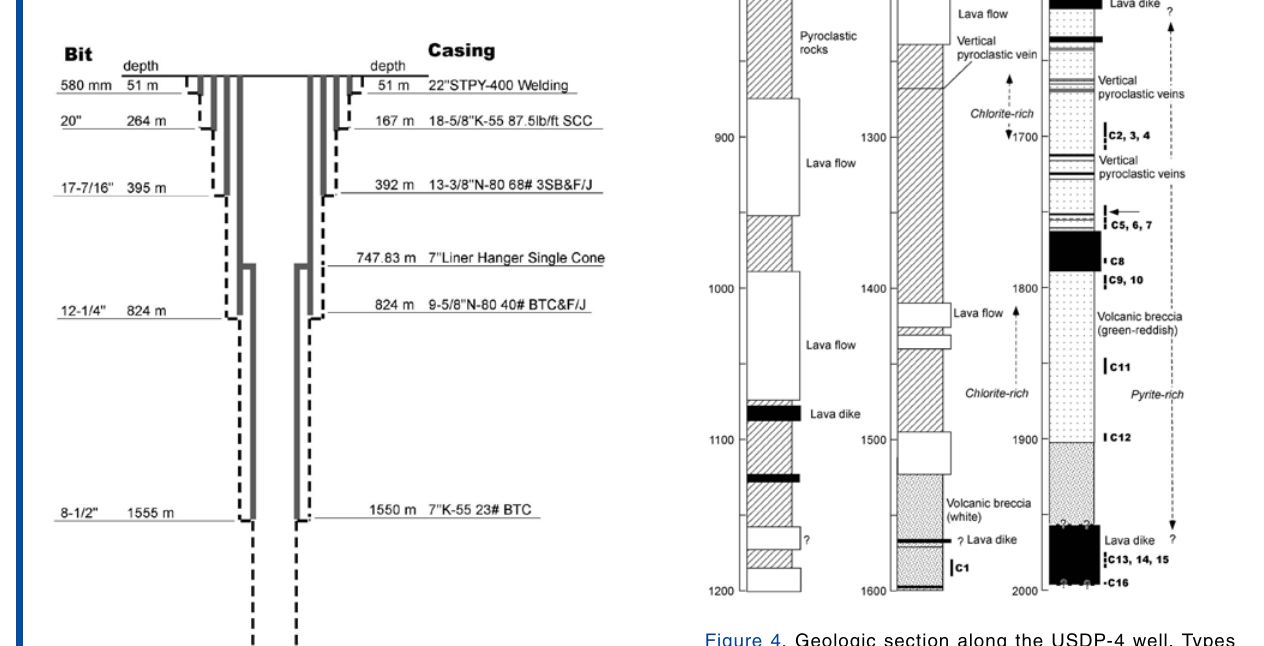
Figure 4. Geologic section along the USDP-4 well. Types A and B of volcanic breccia are colored in green to red and white-colored, respectively, due to difference in the extent of hydrothermal alteration. The pyroclastic vein in Fig. 5 is found at the level with an arrow (1748 m drilled depth).